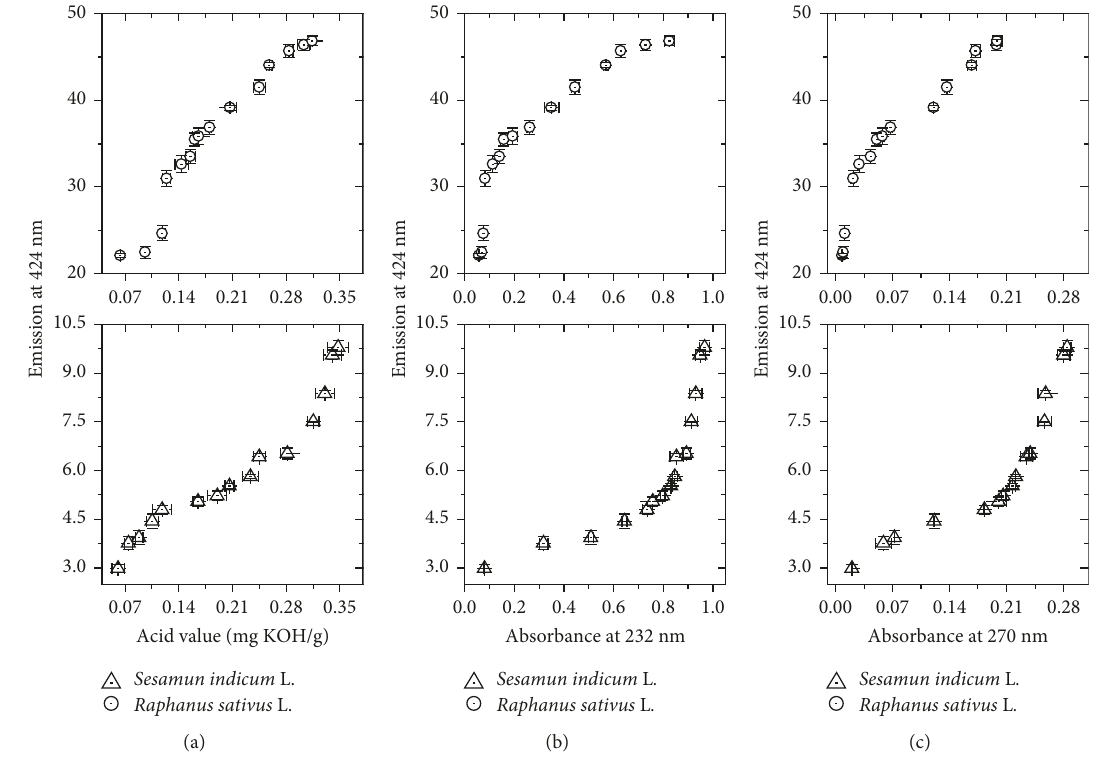
Figure 7: Correlation between emission at 424nm (excitation at 374 and 265nm for S. indicum L. and R. sativus L., resp.) and (a) acid value, (b) absorbance at 232nm, and (c) absorbance at 270nm for SILB and RSLB, respectively. Error bars represent standard deviations.